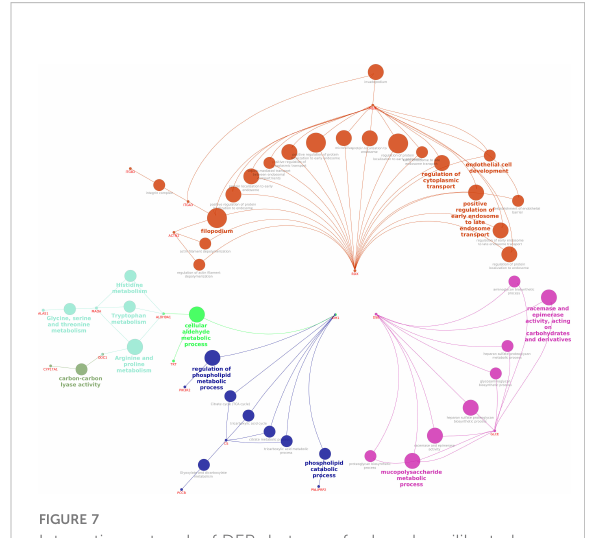
FIGURE 7 Interaction network of DEPs between fresh and equilibrated